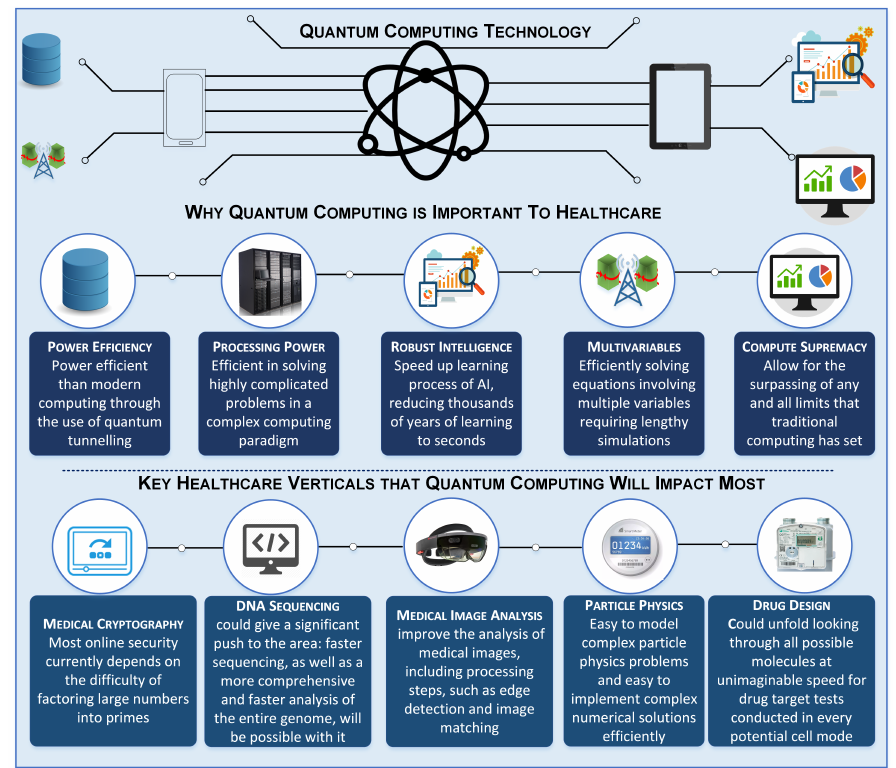
Figure 2. Why use quantum computing and which key verticals will it disrupt?